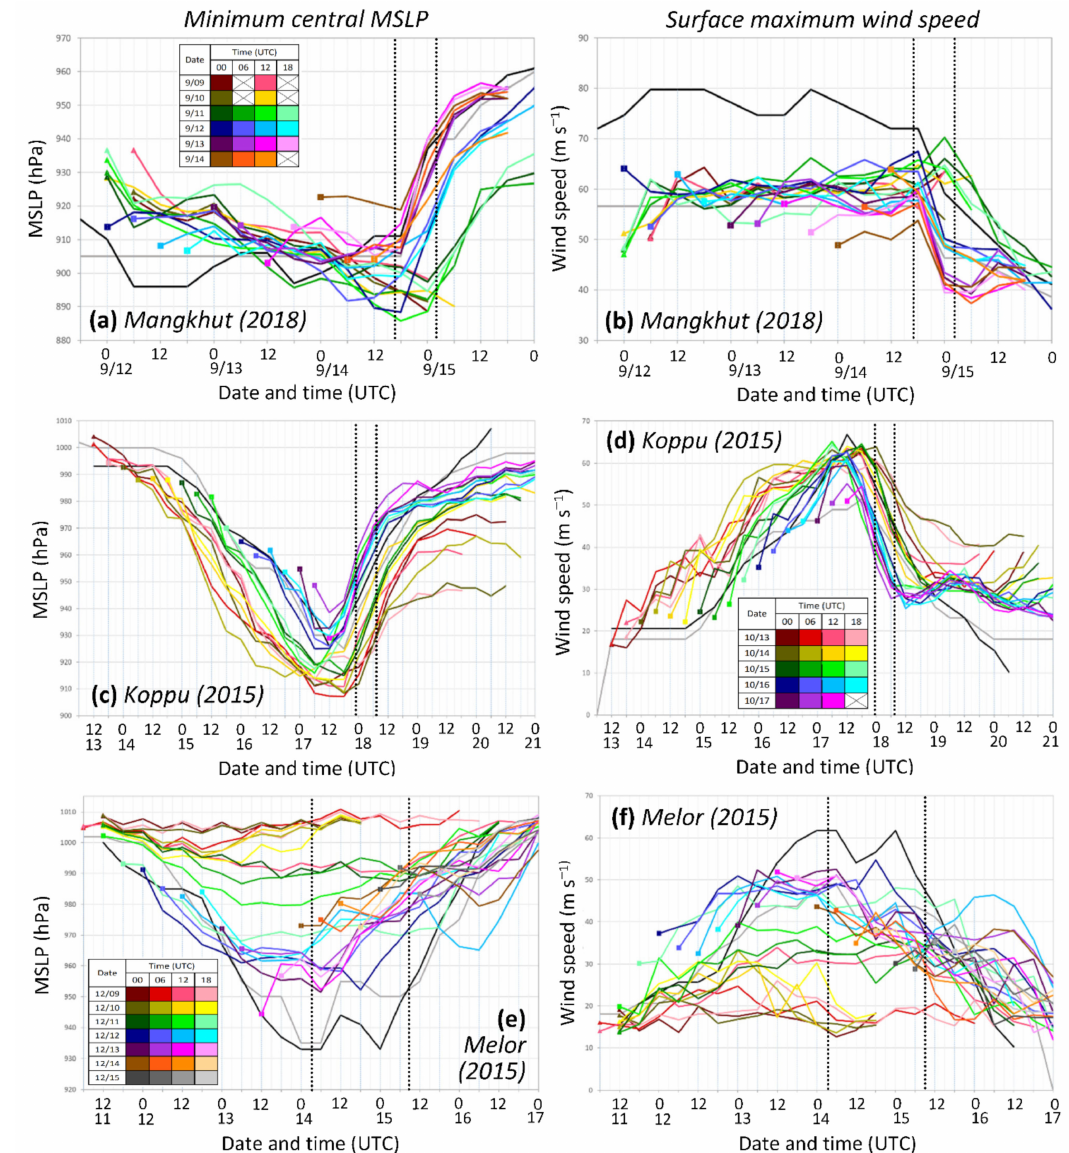
Figure 3. Intensity comparison of ( a ) minimum central MSLP (hPa) and ( b ) near-center maximum surface wind speed (m s − 1 ) for TY Mangkhut (2018) between the JTWC’s (black) and JMA’s (gray) best track data and predictions with time-lagged forecasts at different initial times (color, see inset). The two dotted vertical lines mark the landfall period based on the JTWC’s best track. For each experiment, the initial time is depicted with a square, and a triangle indicates that the initial time was before 0000 UTC on 12 September when the TC center was outside the model domain. ( b – f ) As in ( a , b ), except for ( c , d ) Koppu in October and ( e , f ) Melor in December of 2015,